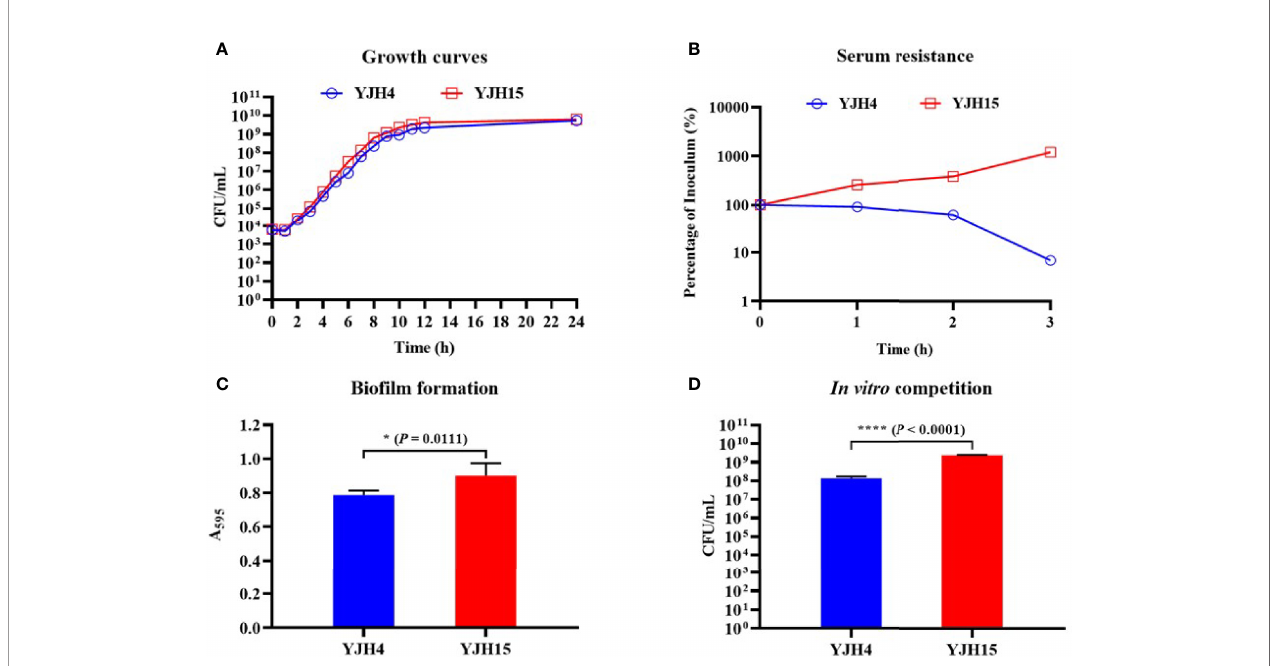
FIGURE 1 | Effect of colistin resistance on K . pneumoniae phenotypic expression. (A) Growth curves of colistin-resistant and colistin-susceptible K . pneumoniae strains. y axis, viable bacterial cells (CFU/mL); x axis, hours of culture. (B) Serum resistance of colistin-susceptible parental strain YJH4 and colistin-resistant YJH15. Serum resistance is described as percentage of viability after 1, 2, and 3hrs of incubation (CFU at speci fi ed time/CFU of the initial mixture). (C) Bio fi lm formation of K . pneumoniae strains. Bio fi lm production was determined by detecting the absorbance at 595nm. Statistical analysis was conducted by performing Student ’ s t test. (* P = 0.0111). (D) In vitro competition assay in M9 medium. K . pneumoniae strains YJH4 and YJH15 were mixed at a ratio of 1:1 and grown together in M9 medium supplemented with 0.4% glucose. CFUs of strains YJH4 and YJH15 were determined after 18hrs ’ co-culturation. (**** P <